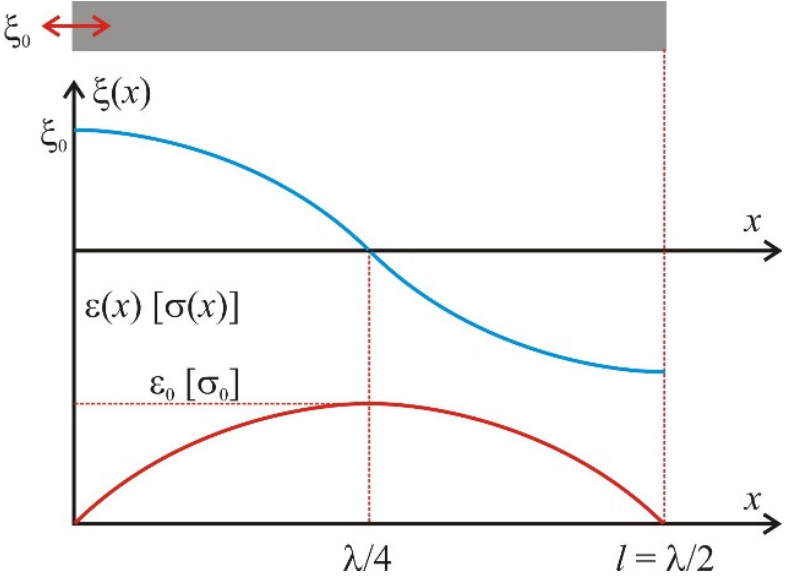
Figure 2. Schematic representation of a half ‐ wave sample and the distribution of displacement, strain and stress amplitudes along it.